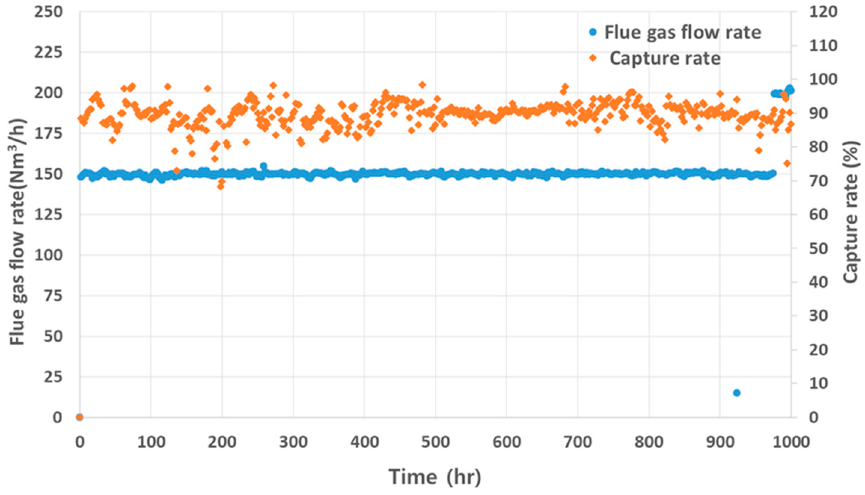
Figure 4. Feed gas flow rate and CO 2 capture rate from IAP operation over 1000 h.